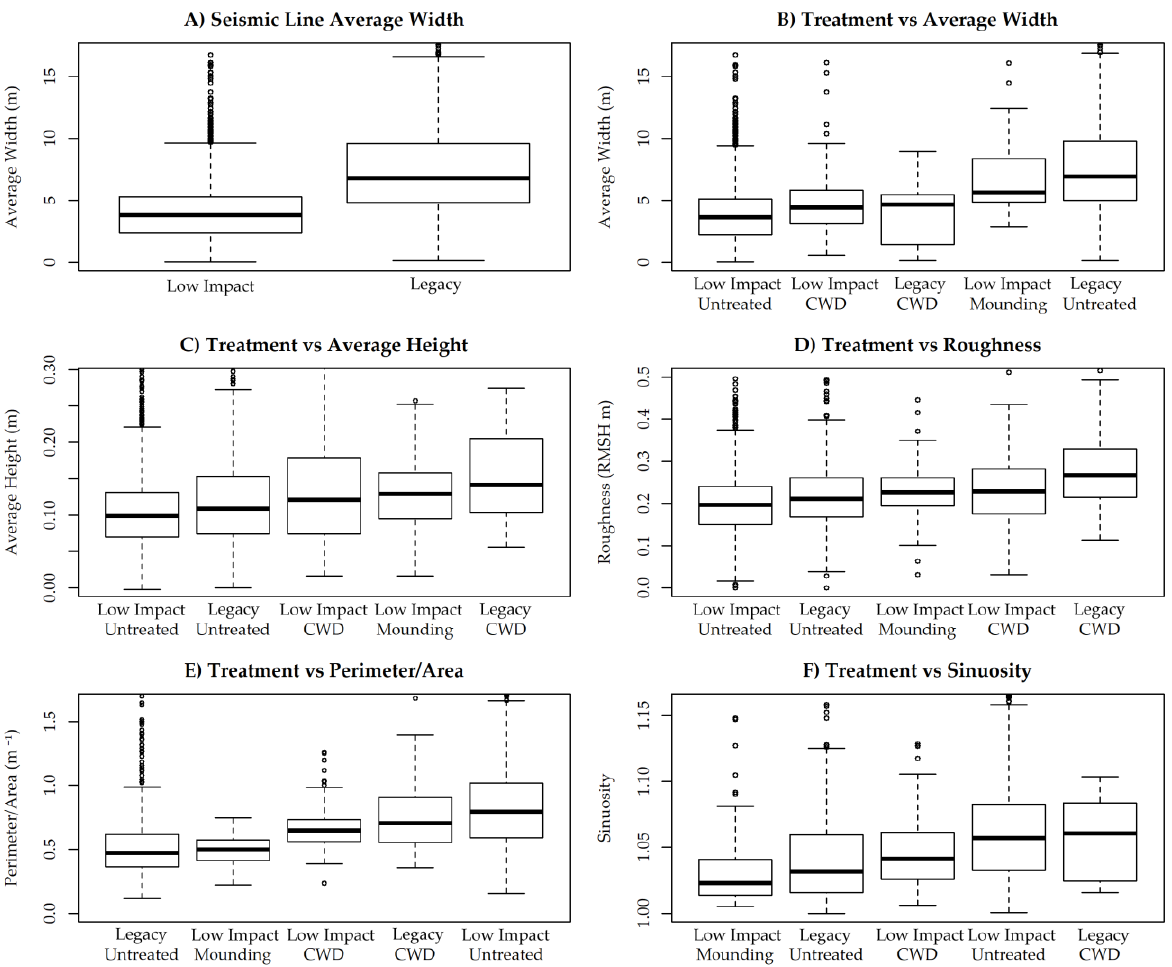
Figure 10. Box plots of dependent variables per line classes in the Kirby study area. Dependent variables include: average width ( A , B ), average height ( C ), roughness ( D , root mean square height, RMSH), perimeter/area ( E ), and sinuosity ( F , unitless).